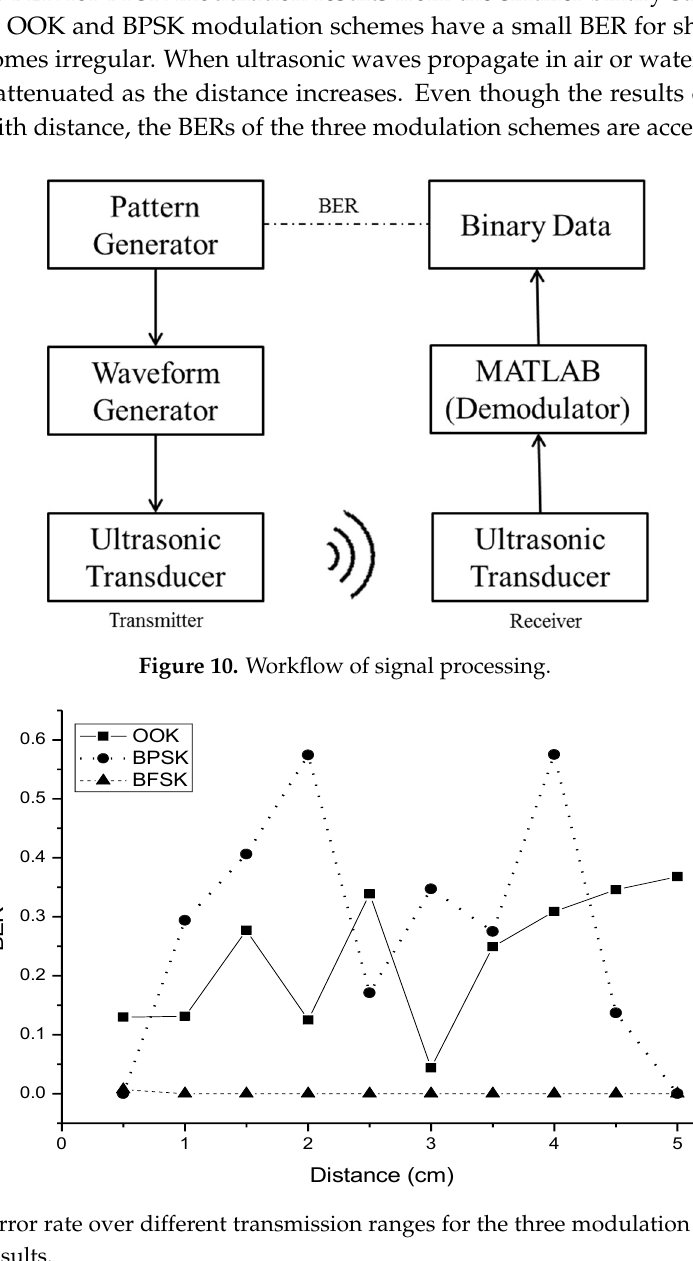
Figure 9. ( a ) Baseband digital signal at 500 bps; ( b ) Transmitted BFSK signal; ( c ) Received BFSK signal in water environment.